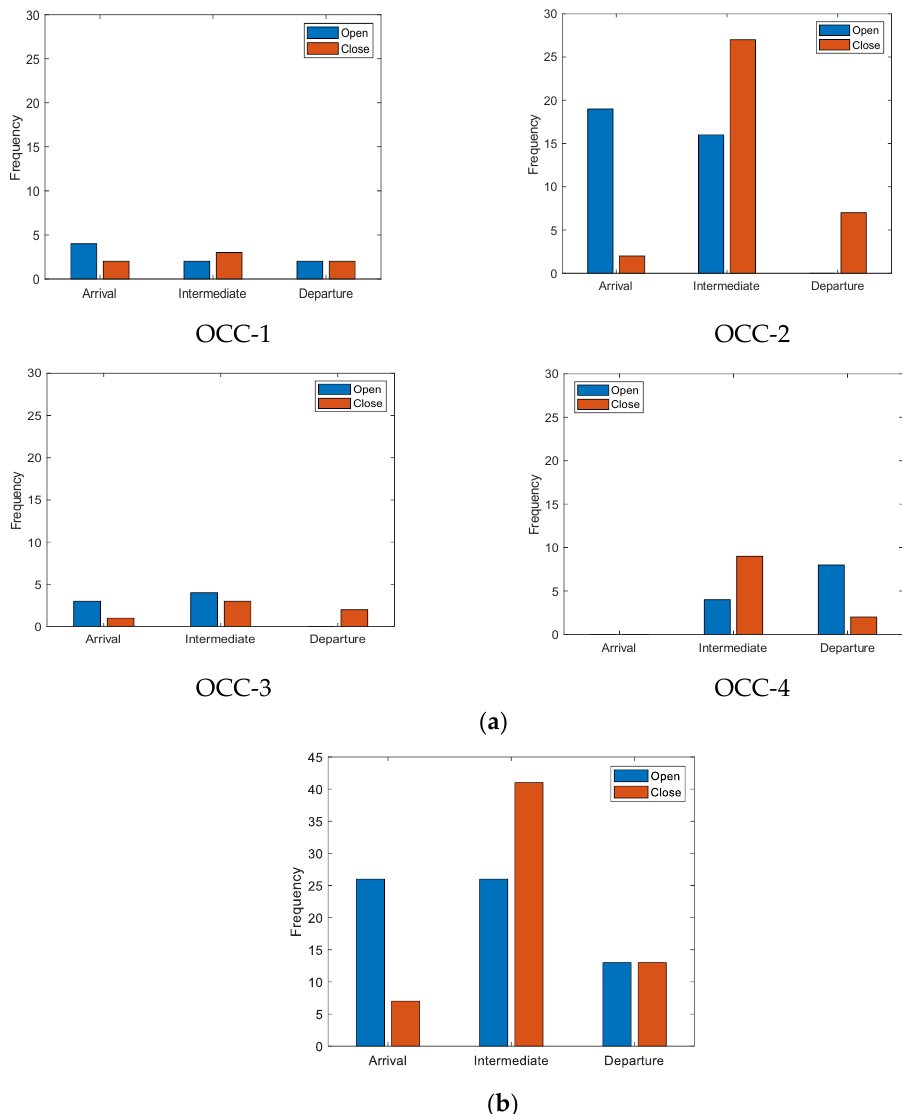
Figure 5. Monitored status of all four windows. ( a ). The time at which the window was opened and closed. ( b ). The time at which the window is opened and closed for all the four participants.